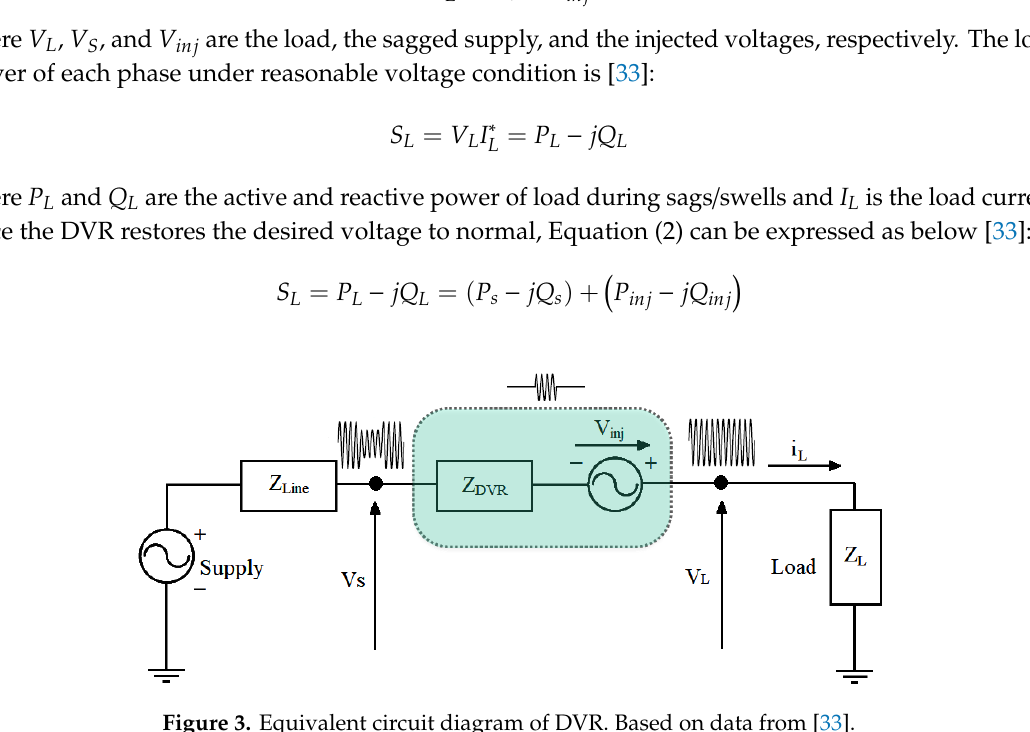
Figure 3. Equivalent circuit diagram of DVR. Based on data from [33].